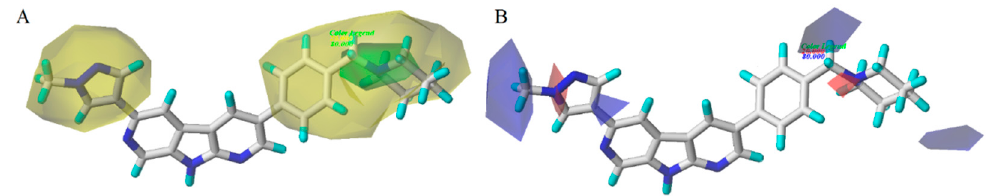
Figure 5. Steric ( A ) and electrostatic ( B ) contours of the CoMSIA model.